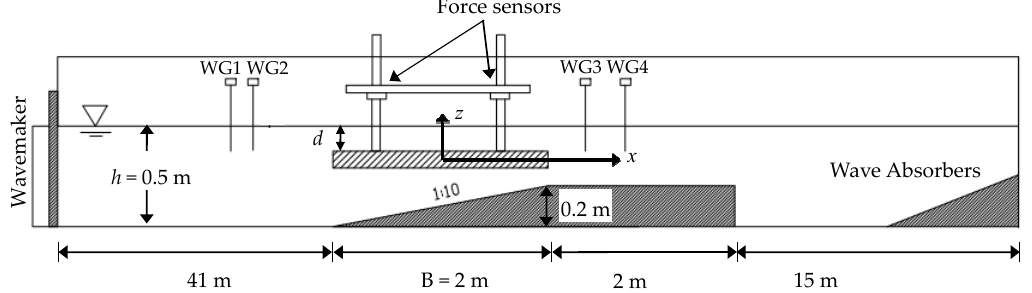
Figure 1. The sketch of the experimental set-up for a submerged horizontal plate of 2 m long and 10 cm thick over a simple 1:10 slope. Not to scale.